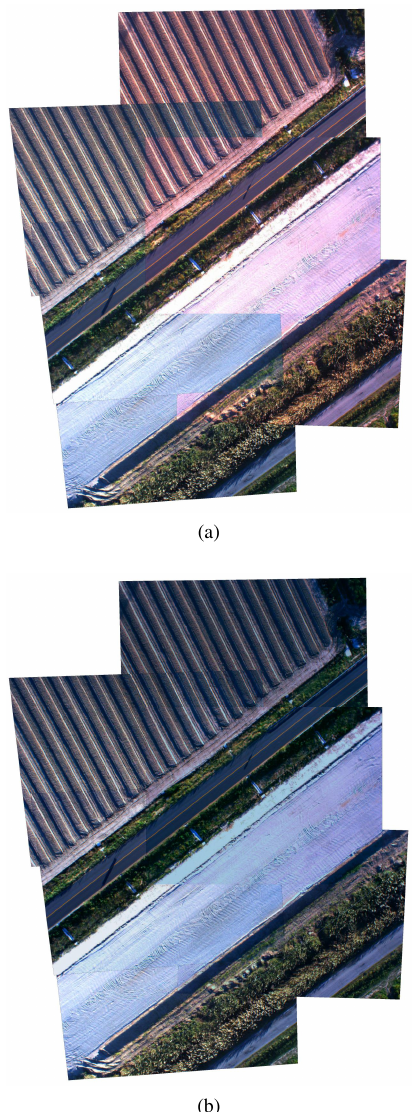
Figure 3. Mosaic before (a) and after (b) colour correction. patches, increasing at the same time the total length of the seam- lines. This issue can be faced searching for a subset of images with the property that no one is completely covered by the union of the others. An iterative greedy approach can be followed to discard redundant elements, considering an image at a time and evaluating if its projection in the mosaic reference frame is com- pletely covered by the projection of the other images. If so, the current image is discarded and the dataset is updated. The pro- cess is repeated until all the remaining elements are verified. The drawback of this procedure is that it is order-dependent and does not guarantee that the minimum subset is kept. The process can be driven by arranging the dataset in a convenient way, since the first images analysed are more likely to be discarded. A possible choice is to sort the images according to their colour balancing or to the alignment